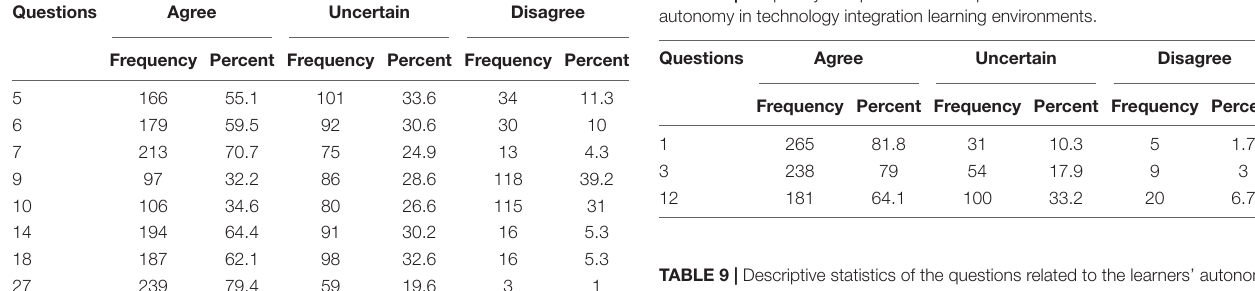
TABLE 6 | Frequency and percent of the questions related to the learners’ motivation in technology integration learning environments. Questions